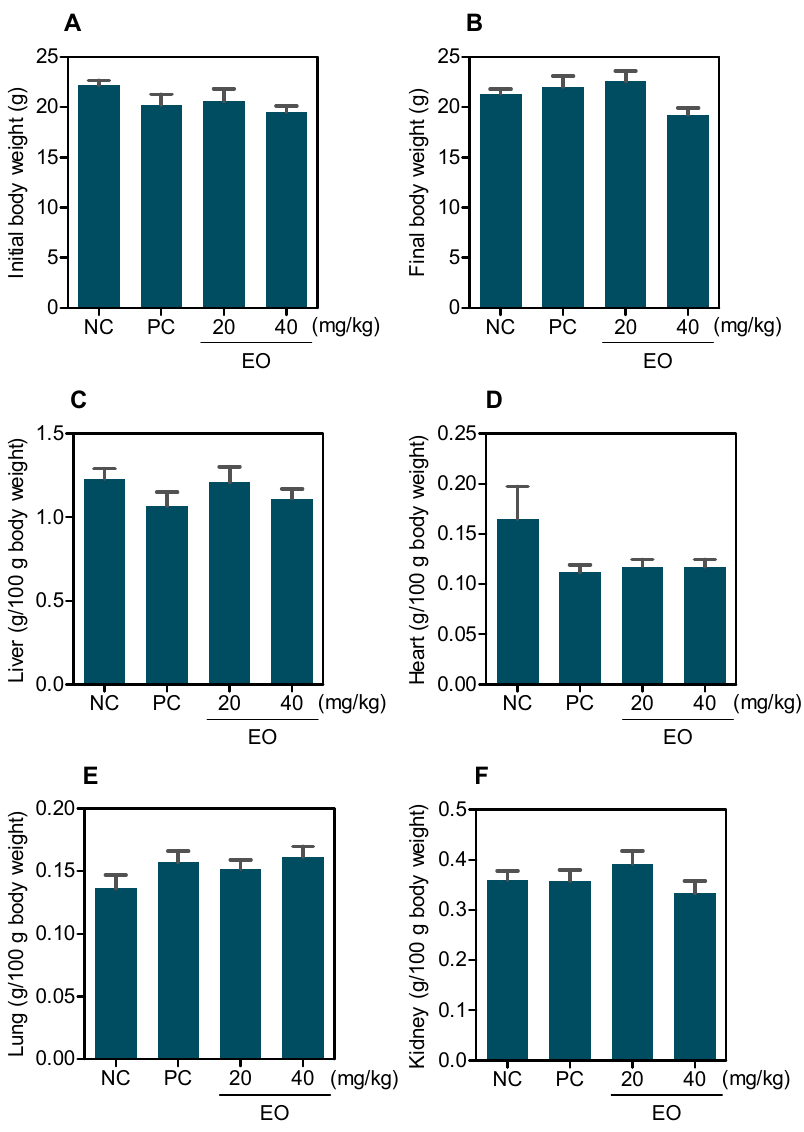
Figure 6. Effect of G. olivacea leaf EO on body and relative organ weight from C.B-17 SCID mice with HepG2 cell xenografts. ( A ) Initial body weight. ( B ) Final body weight. ( C ) Liver. ( D ) Heart. ( E ) Lung. ( F ) Kidney. Negative control ( NC ) was treated with vehicle (5% DMSO) used for diluting EO, and